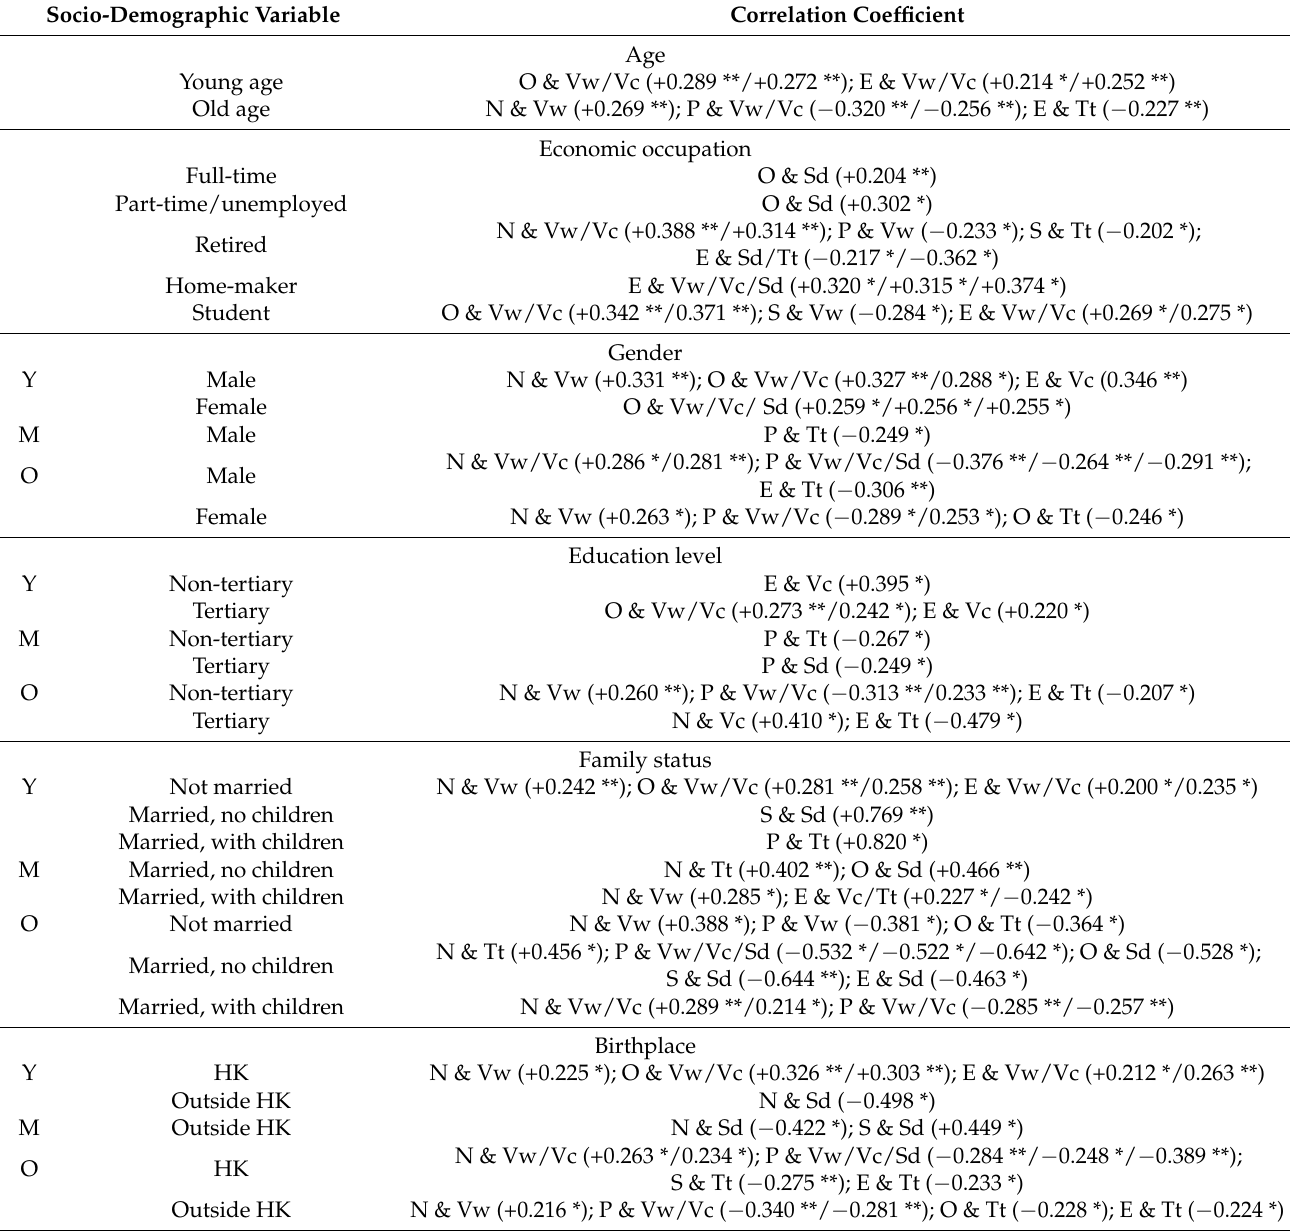
Table 6. The correlations between the respondents’ engagement level in five activity clusters 1 and visiting patterns with reference to six socio-demographic factors, determined by Spearman’s correlation coefficients of the PCA component scores and ordinal level of the visit frequency of summer/warm periods (Vw) and winter/cool periods (Vc), stay duration (Sd) and travel time